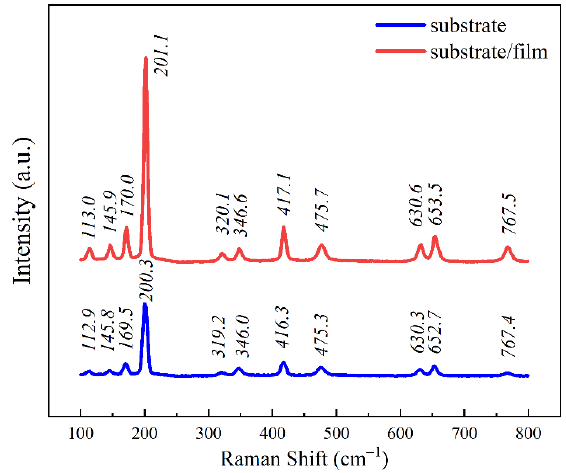
Figure 2. Raman spectra of Ga 2 O 3 film and substrate.